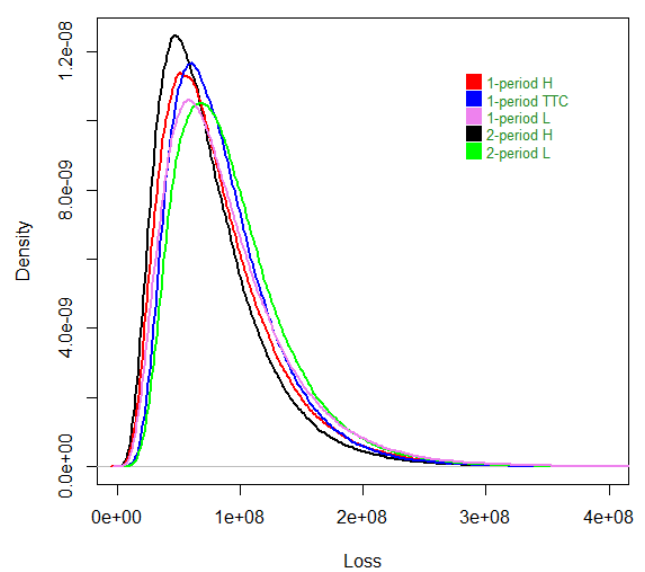
Figure 3. The loss